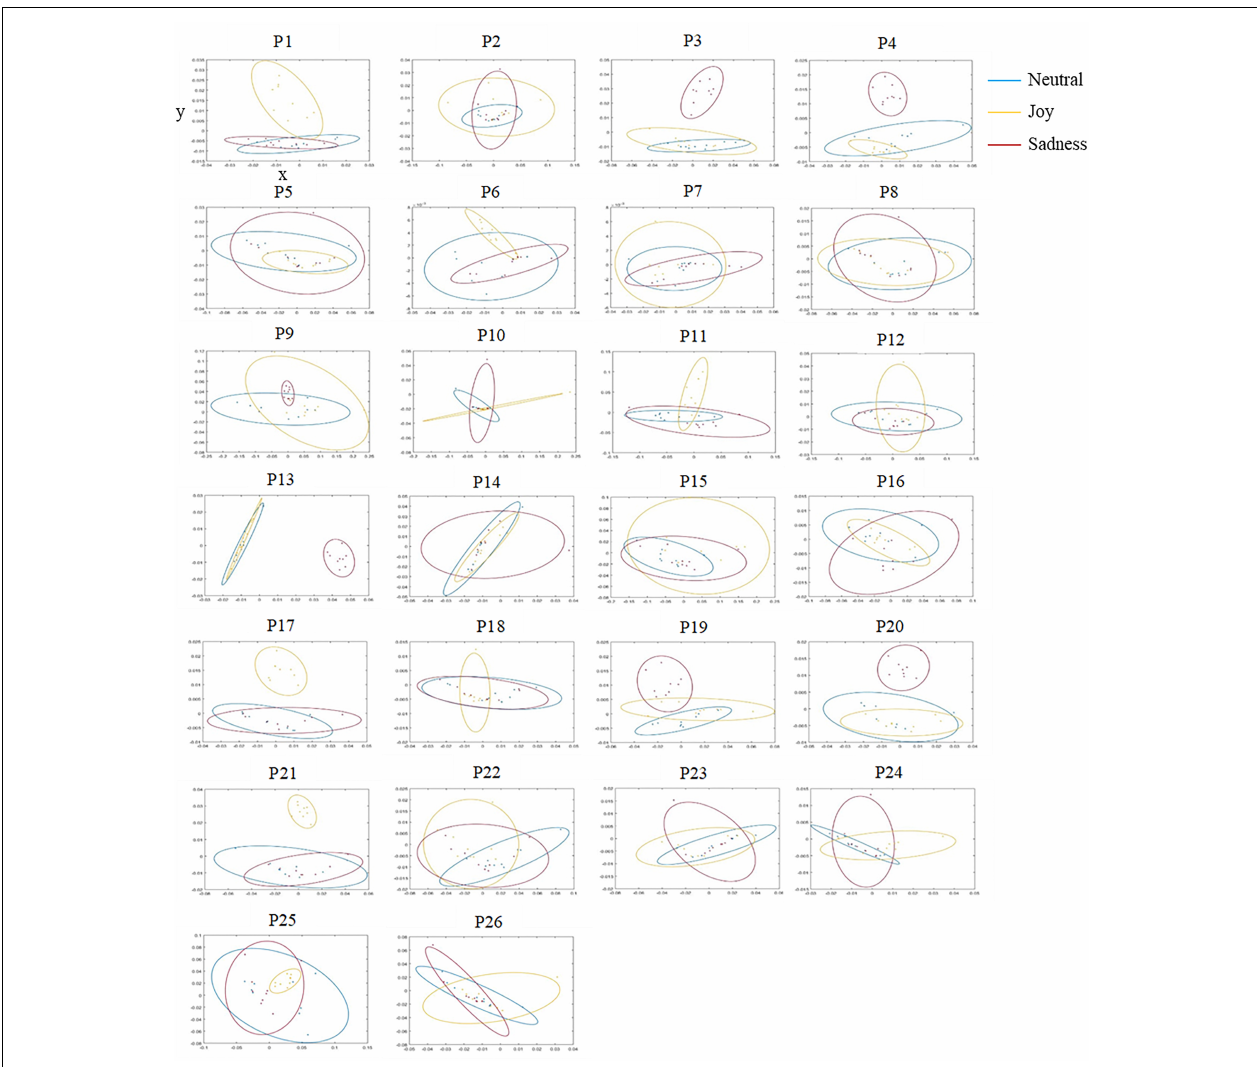
FIGURE 2 | Individual motor signatures (IMS) of each participant in the similarity space, for the three tested emotional conditions neutral (in blue), joy (in yellow), and sad (in red). The nine small dots in each ellipse correspond to the nine individual trials by emotional condition. X -axis and Y -axis represent the first two dimensions of the multidimensional scaling analysis (MDS), proper to each participant (see text for